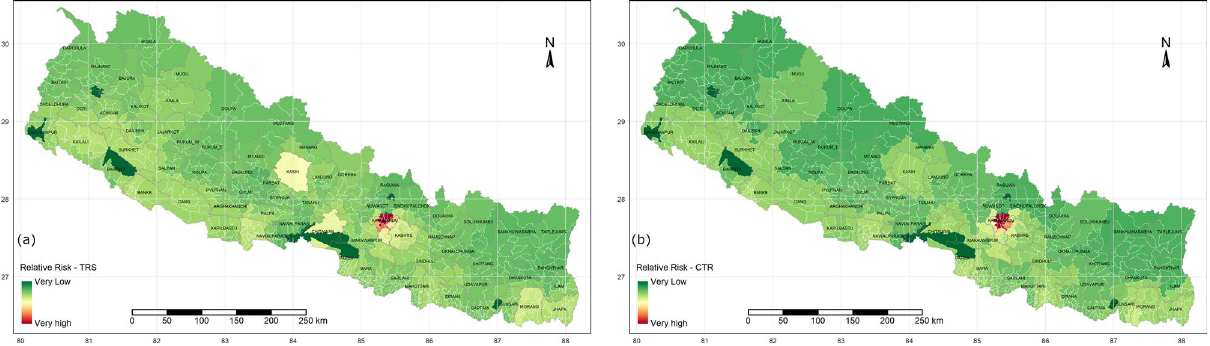
Figure 2. Relative risk maps of overall risk scenario, overall risk score of Nepal ( a ) and COVID-19 transmission risk (CTR) ( b ) prior to pandemic. Maps were produced from R programming version 3.5.3; source: https ://